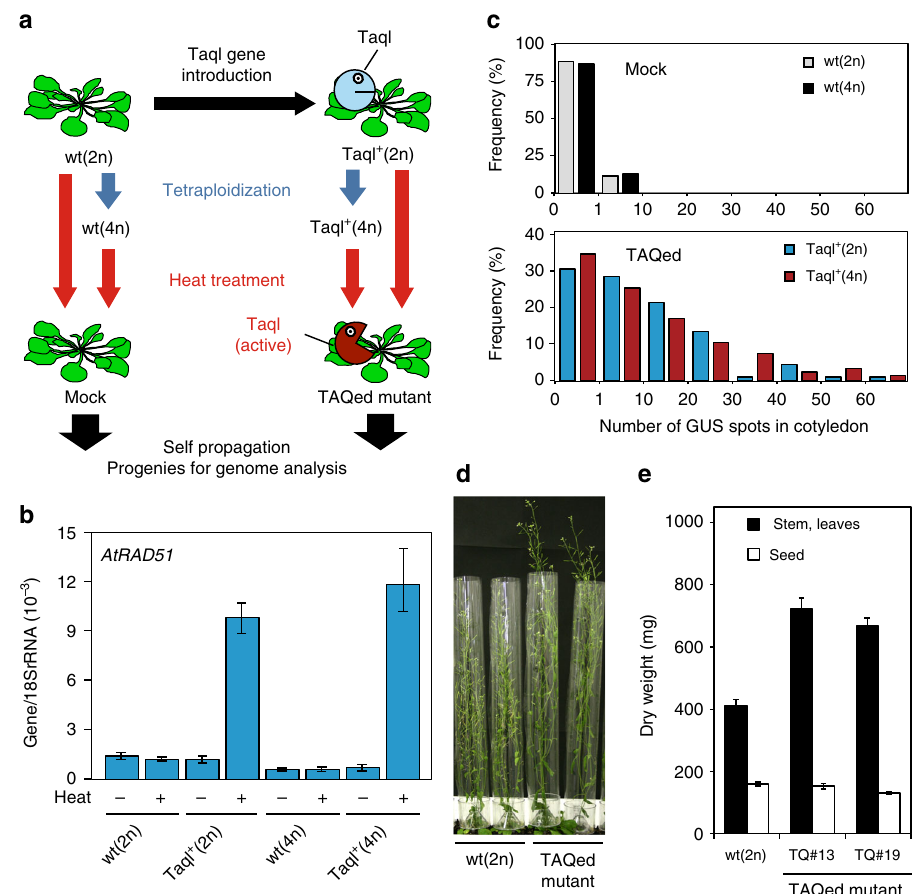
Fig. 4 TaqI-induced DSBs and mutations induced in Arabidopsis plants. a Experimental scheme of induced genome rearrangements in diploid and tetraploid plants. Diploids and tetraploids harboring TaqI transgene are indicated as TaqI + (2n) and TaqI + (4n), respectively. b AtRAD51 mRNA expression following TaqI activation. Data represent the mean±SEM ( n = 3). c Frequency distribution of blue spots by GUS-reporter gene recombination in cotyledons of TAQed diploid [TaqI + (2n)] and tetraploid [TaqI + (4n)] plants. d , e The biomass growth phenotype increased in TAQed mutants. d Image shows control and TAQed mutant (#13, left; #19 right) plants grown in soil for 54 days, e dry weight of plants grown in soil for 14 weeks. Data represent the mean±SEM ( n =